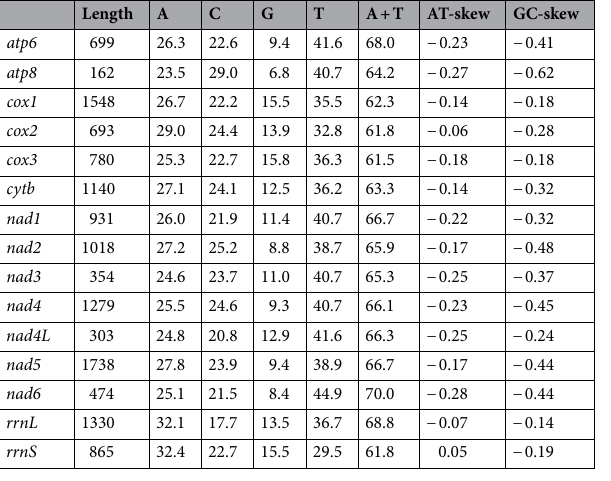
Table 2. Nucleotide composition (%) of 13 protein-coding genes and rRNAs, and the skewness of Travisia sanrikuensis .